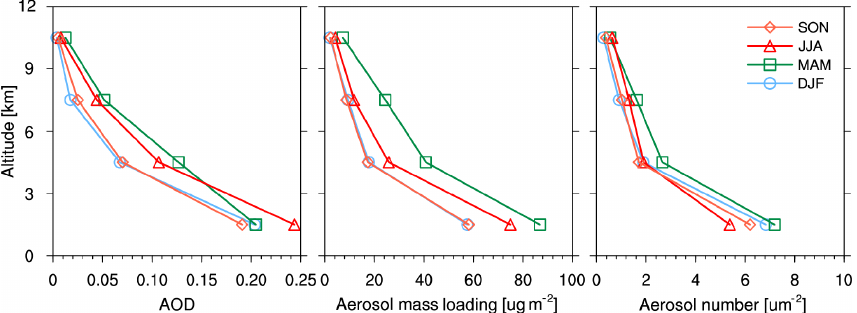
Figure 14. Vertical distribution of seasonal AOD, aerosol mass loading (micrograms per square meter), and aerosol number (particles per square micrometer) over the TP from the WRF-Chem simulation averaged over the period of